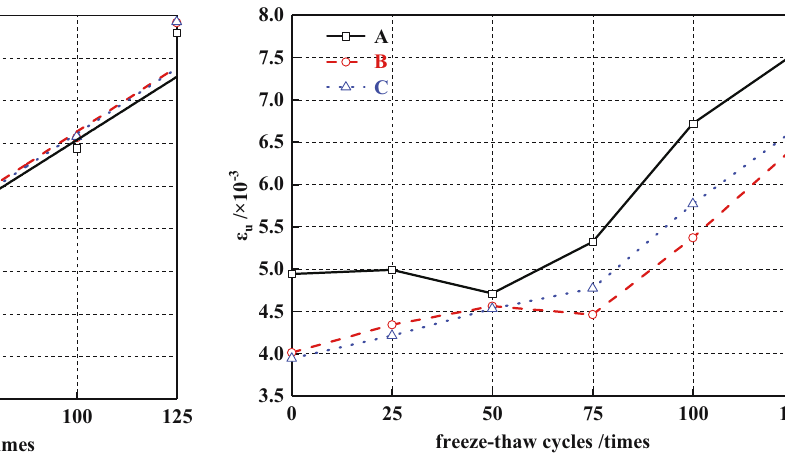
n 0 Relationship with the number of freeze – thaw cycles. Figure 16: Relationship between ε u and freeze – Figure 15: ε ε 00